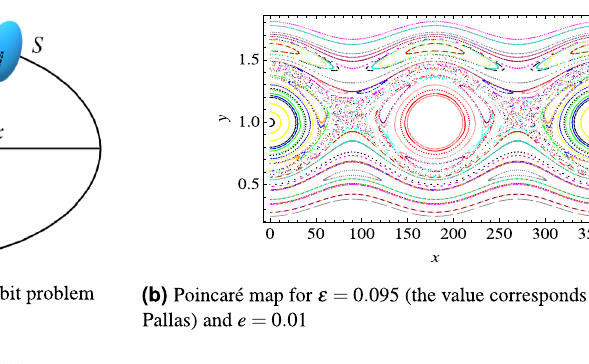
Figure 2. The spin–orbit